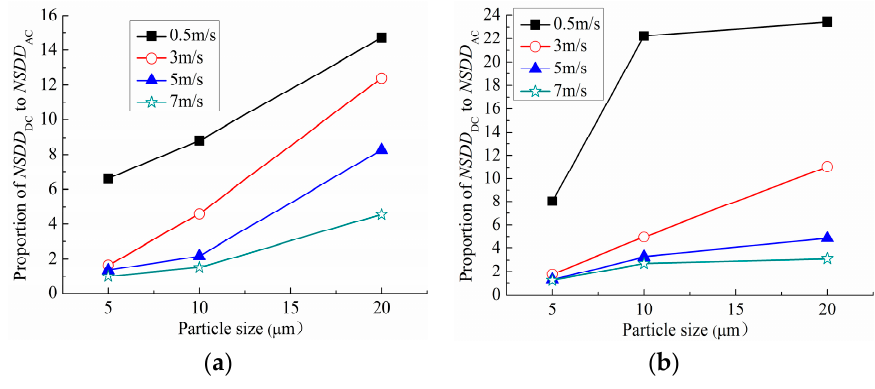
Figure 9. Proportion of NSDD DC to NSDD AC versus particle size curves, ( a ) porcelain three-umbrella insulator; and ( b ) porcelain bell jar insulator.